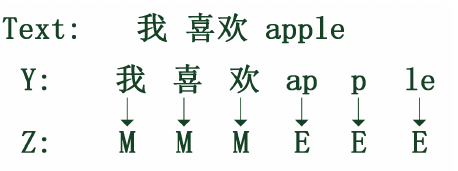
Figure 3. An example: Y label sequence corresponding to Z label sequence.